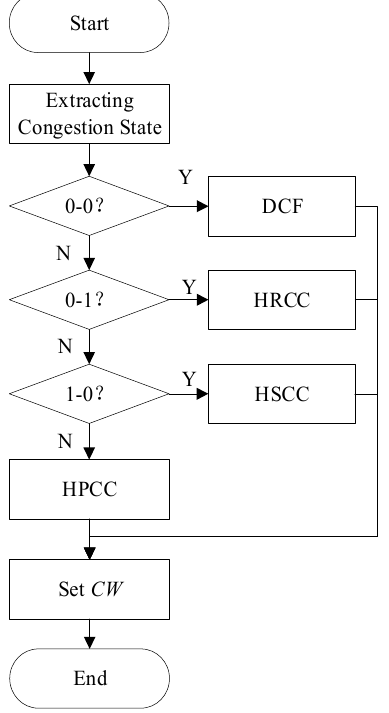
Figure 6. Contention window adjustment strategies of HBCC.